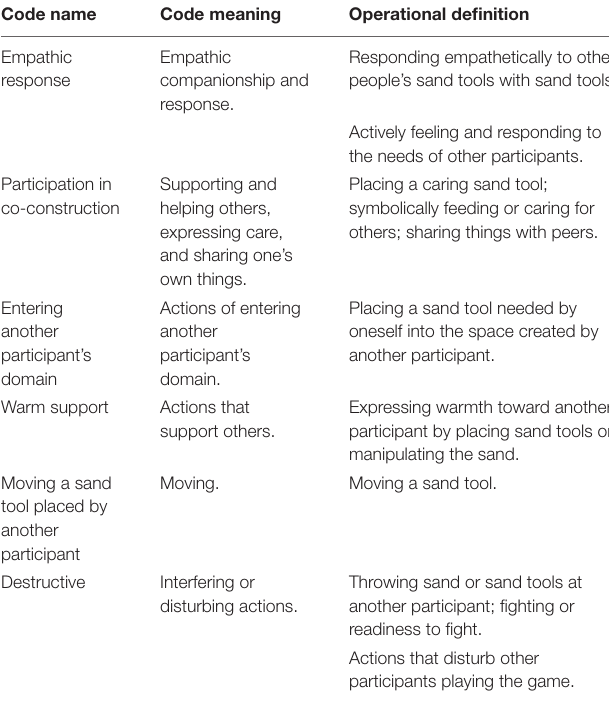
TABLE 1 | Interaction behavior coding of